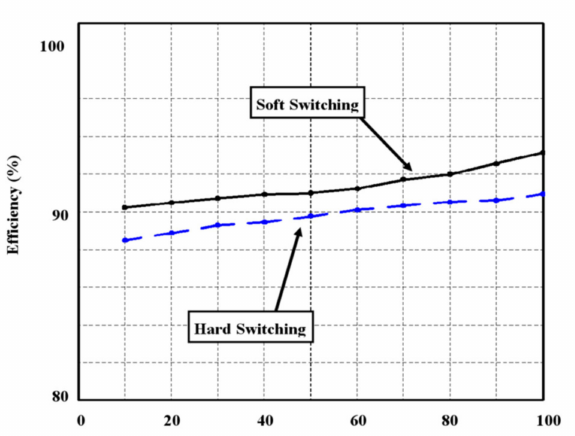
Figure 18. Efficiency comparison between with (real line) and without (dotted line) the proposed soft switching